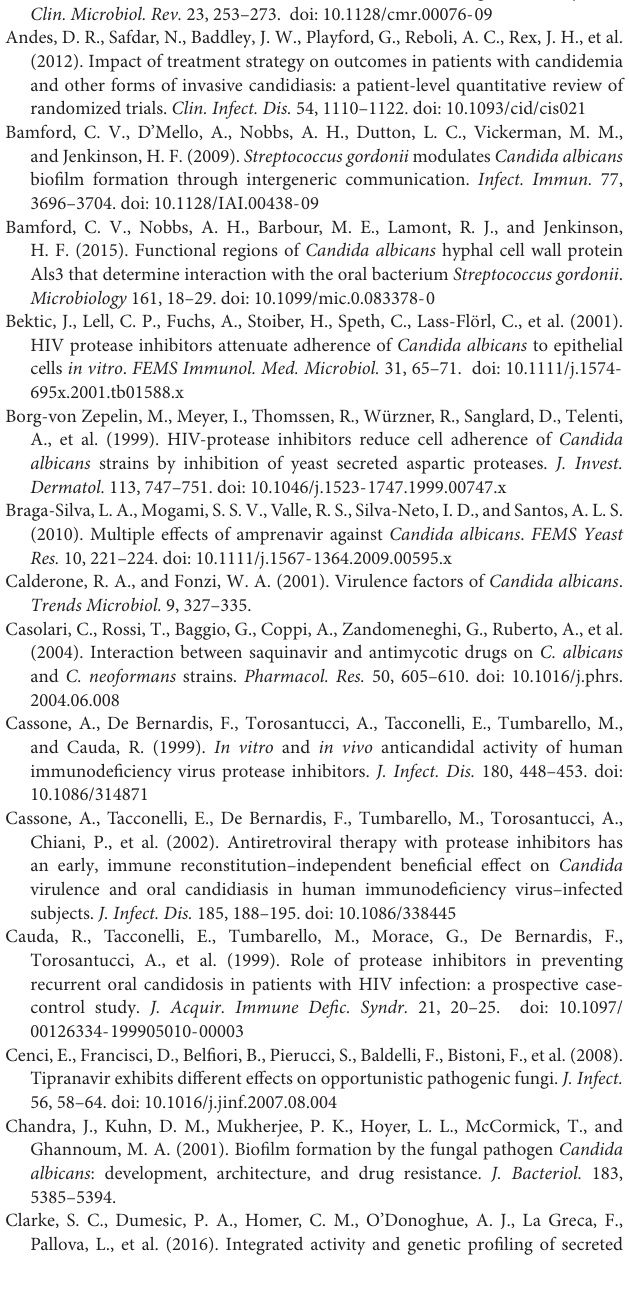
TABLE S1 | Compiled data and statistics from the standalone and combination Sustained Inhibition and Disruption Optical Density Biofilm Assays as well as the BIC Sustained Inhibition Optical Density Biofilm Assay. For each compound, the